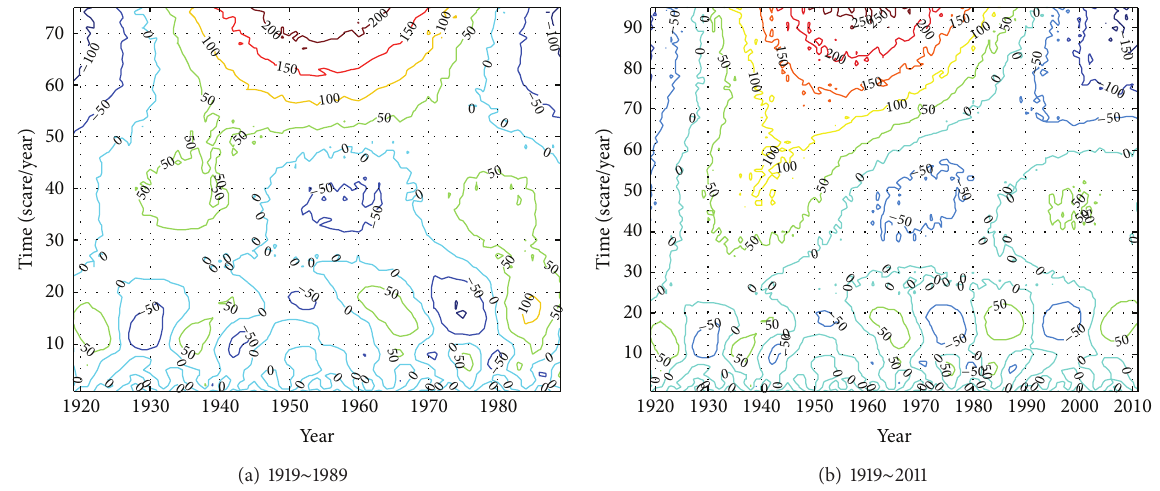
Figure 6: Results of the wavelet variance analysis for runoff periodicity in 1919–1989 and 1919–2011.